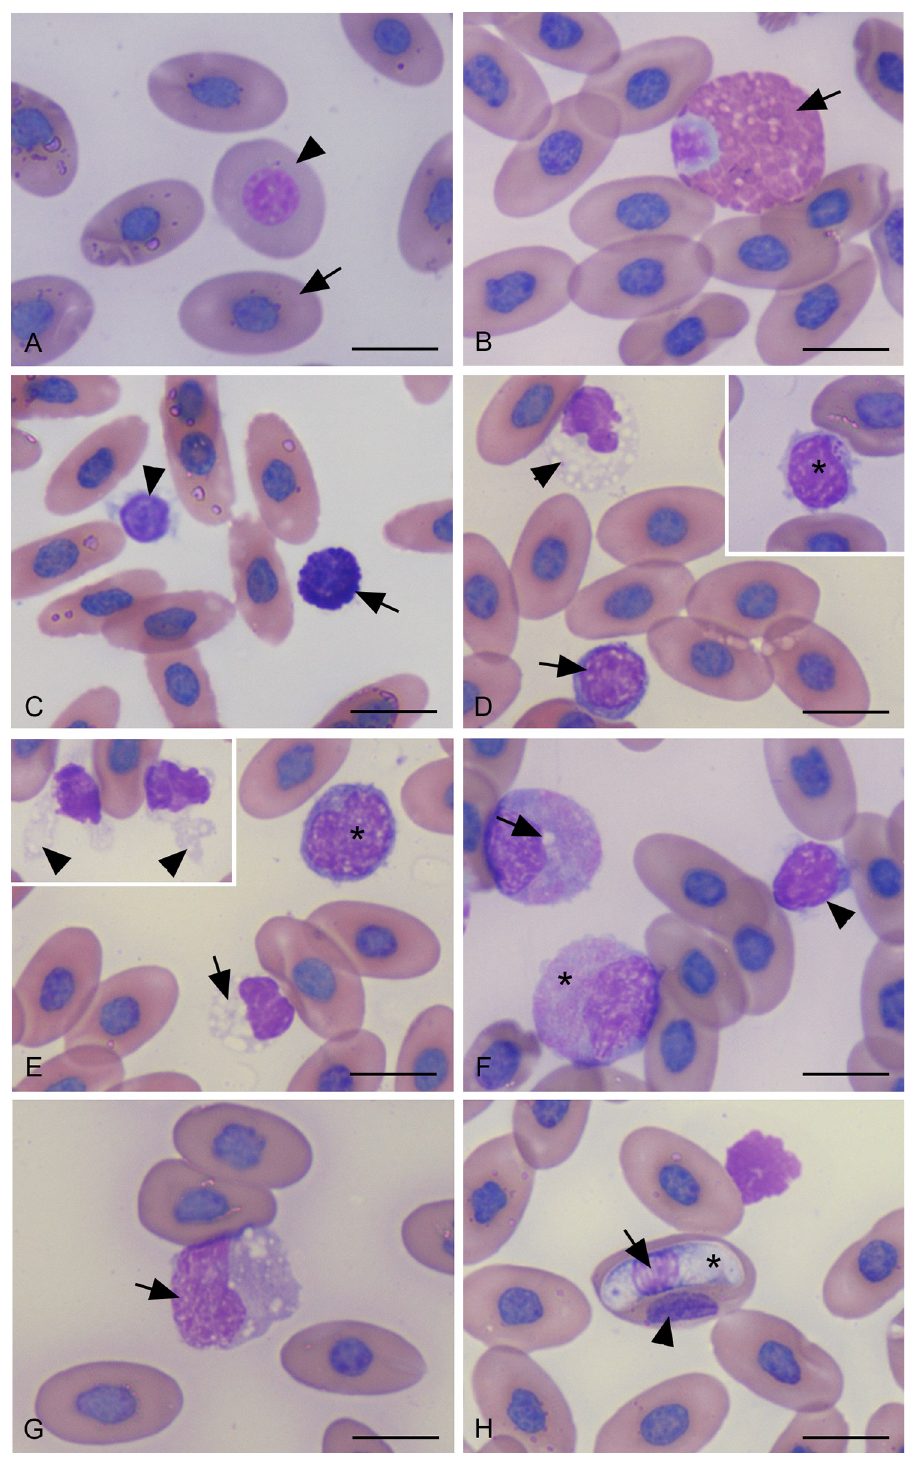
Fig 3. Light micrographs of peripheral blood cells from Asian water monitor (Modified Wright Giemsa stained, horizontal bar: 10 micrometers). (A) Erythrocyte (arrow), polychromatic erythrocyte (arrow head). (B) Heterophils shows eccentric rounded nucleus with abundant cytoplasmic eosinophilic fusiform granules (arrow). (C) Basophil (arrow), small lymphocyte (arrow head). (D) Thrombocyte (arrow head) with vacuolated cytoplasm, Small lymphocyte (arrow), Inset shows small lymphocyte with intracytoplasmic azurophilic granules (asterisk). (E) Large lymphocyte